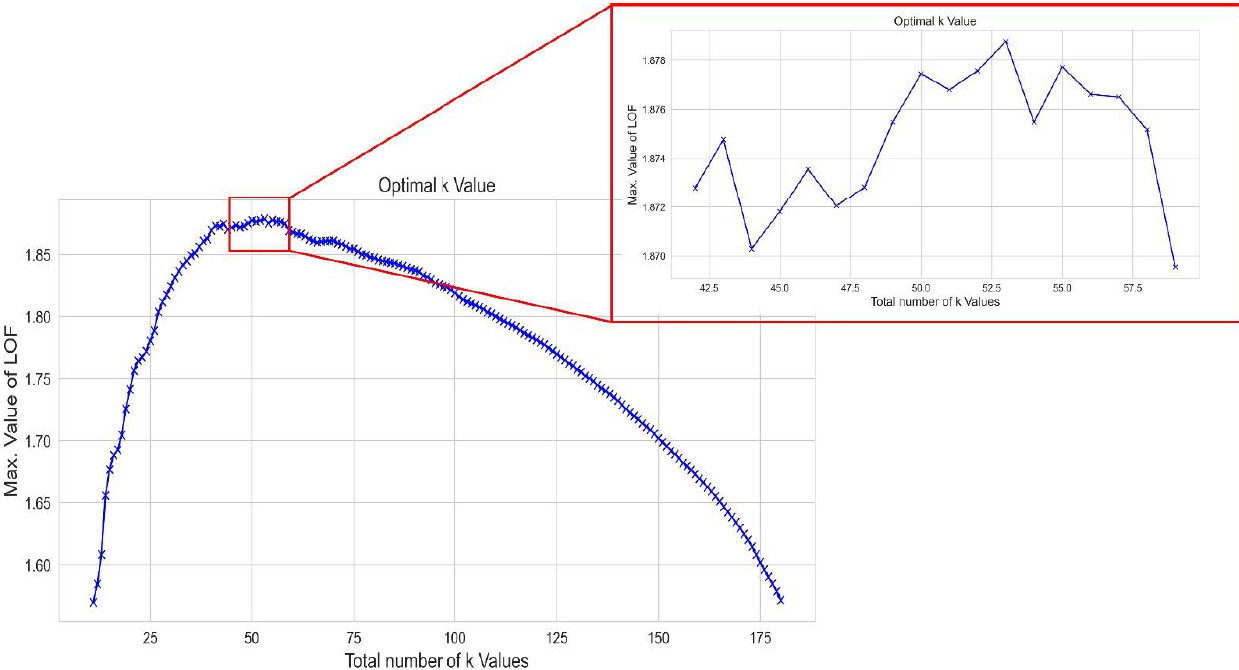
Figure 6. Maximum LOF scores across all flights at Minneapolis airport for different k values.